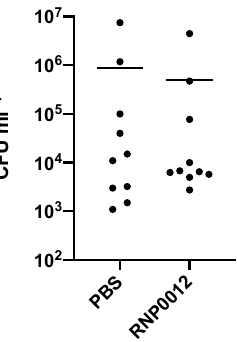
Figure 5. Efficacy of RNP0012 in a murine model of bacterial keratitis. Corneal scratches were inoculated with 10 7 CFU mL − 1 UAMS-1 and dosed with PBS (n = 10) or 50 µM RNP0012 (n = 9) every 6 h for 48 h.